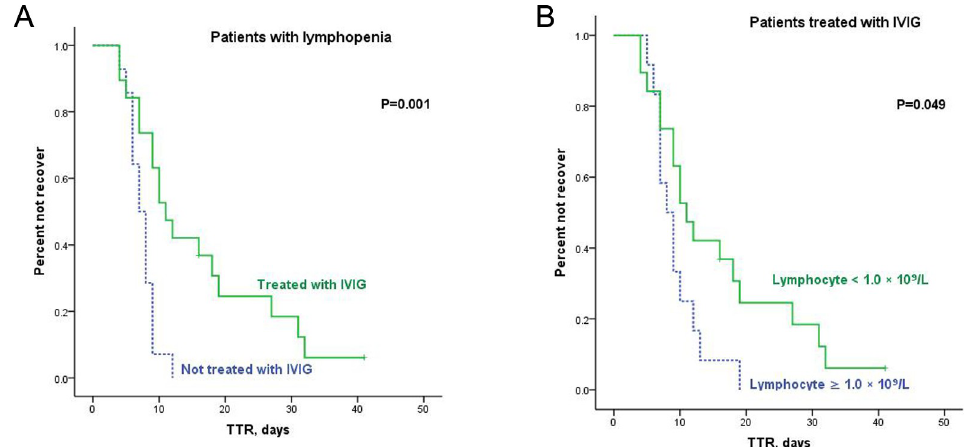
Fig 6. Kaplan-Meier curves for TTR in patients receiving IVIG treatment. (A) Kaplan-Meier curves for TTR according to treatment of IVIG in patients with lymphopenia; (B) Kaplan-Meier curves for TTR according to lymphocyte count in patients treated with